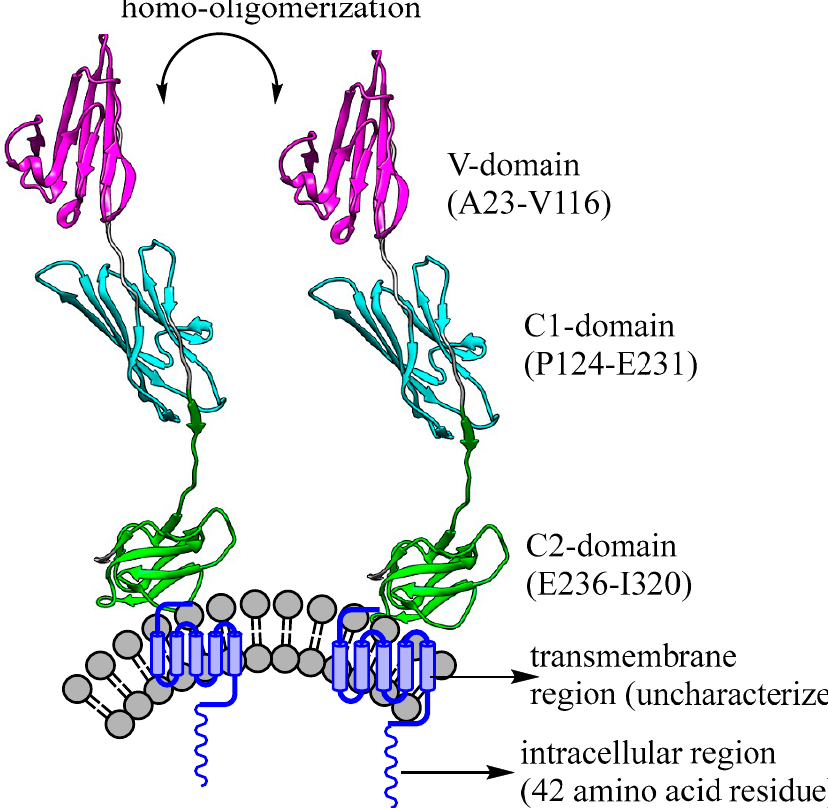
Figure 5. Schematic illustration of RAGE protein and its various intracellular and ectodomains; the ectodomain V-C1 (A23 to E231) is made of hydrophobic and positively charged residues, including Lys39,43,37,44,52,62,110,123,140,174,169; and Arg29,216,57,98,116,48,77,104,178, 221,228; PDB ID: 4LP5) and thereby binds to the negatively charged ligands, including AGEs, S100 family of proteins, high mobility group box1 protein (HMGB1) and β -amyloid (A β ). The ligand binding to the VC1 domain elicits signaling cascade events transmitted through the 42-residue intracellular RAGE domain [71,72].